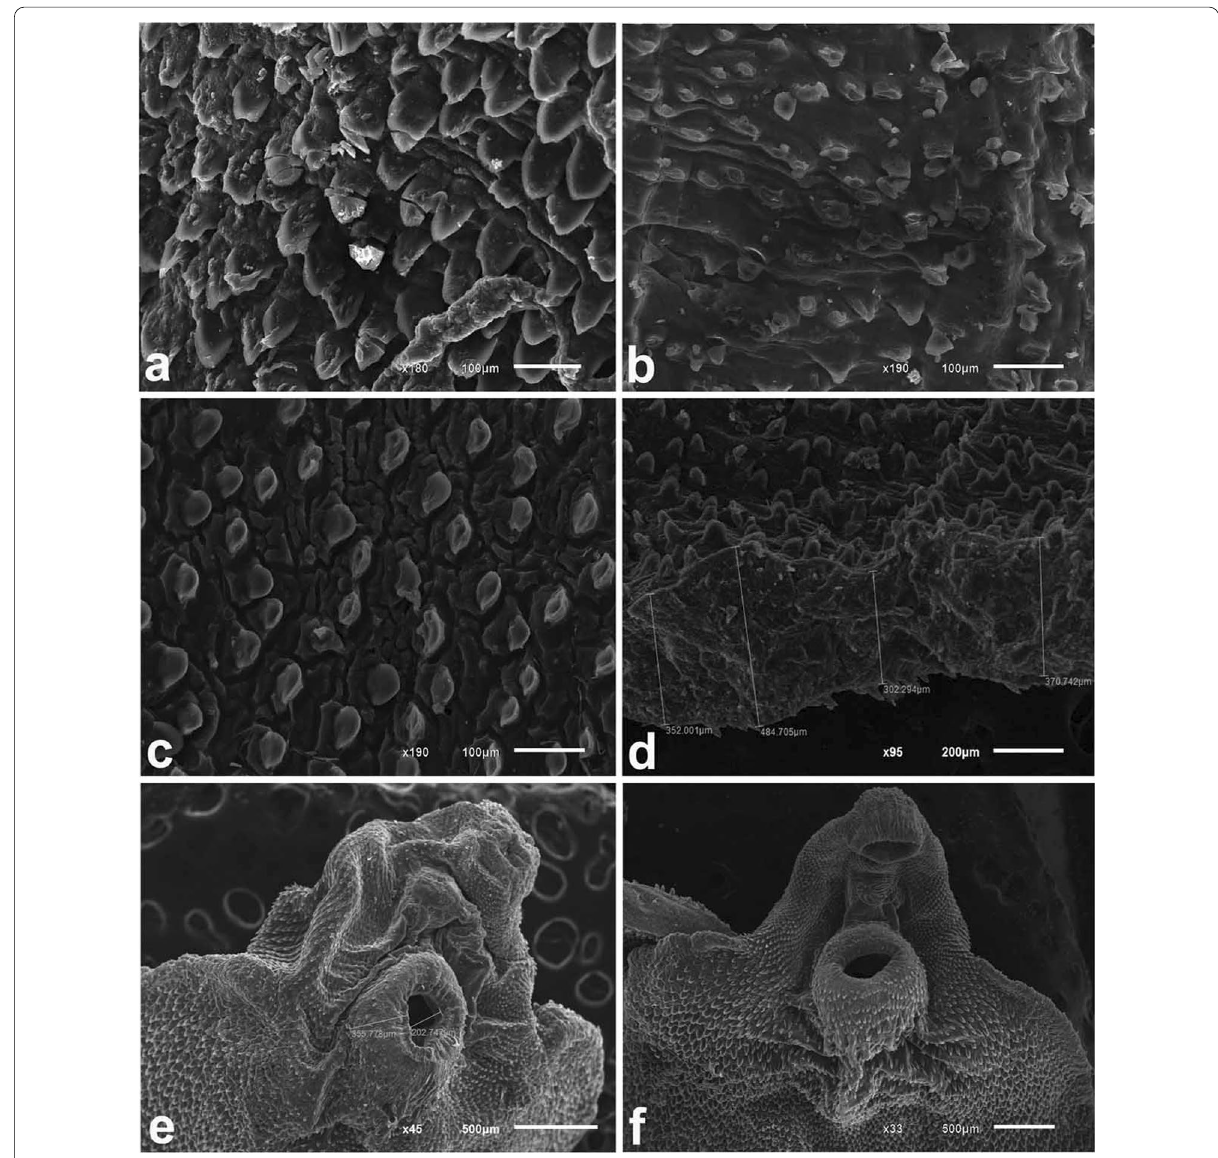
Fig. 2 SEM of nitroxynil‑treated Fasciola gigantica adult worm. a Anterior tegument surface. b , c Middle and tail tegument surface showing severe furrowing, and severe destruction in the spines. d , e The thickness of cuticle 302–484 µm. e , f Ventral sucker